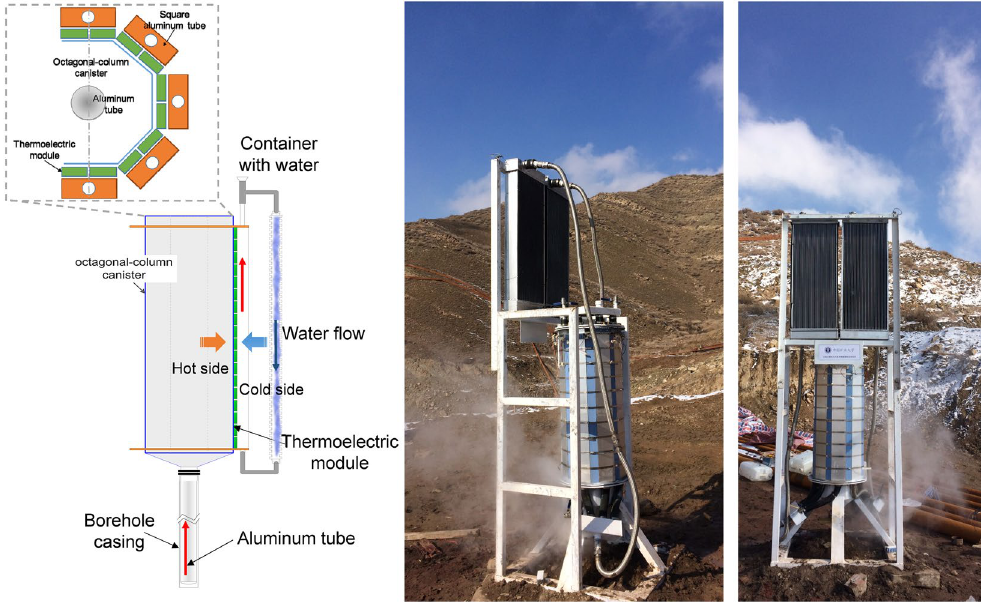
Figure 3. Clean power generation system from the intractable natural coalfield